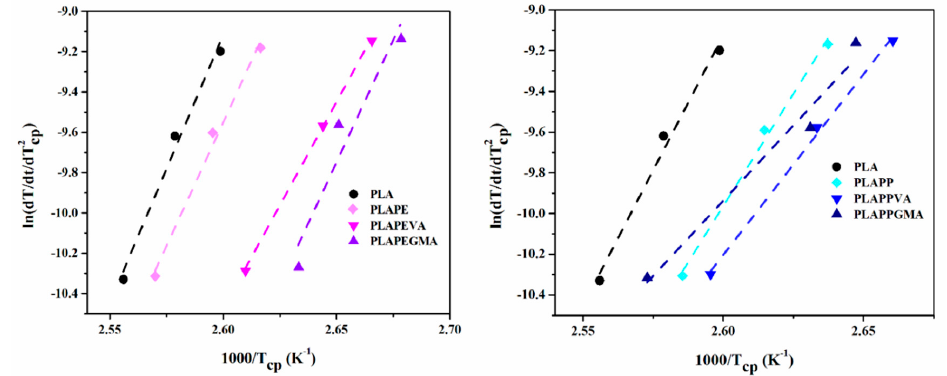
Figure 9. Plots for evaluating the crystallization activation energy for the comparison between different compositions of compatibilized and non compatibilized PLA/POE blends with neat PLA for each grade of POE based on the Kissinger model.